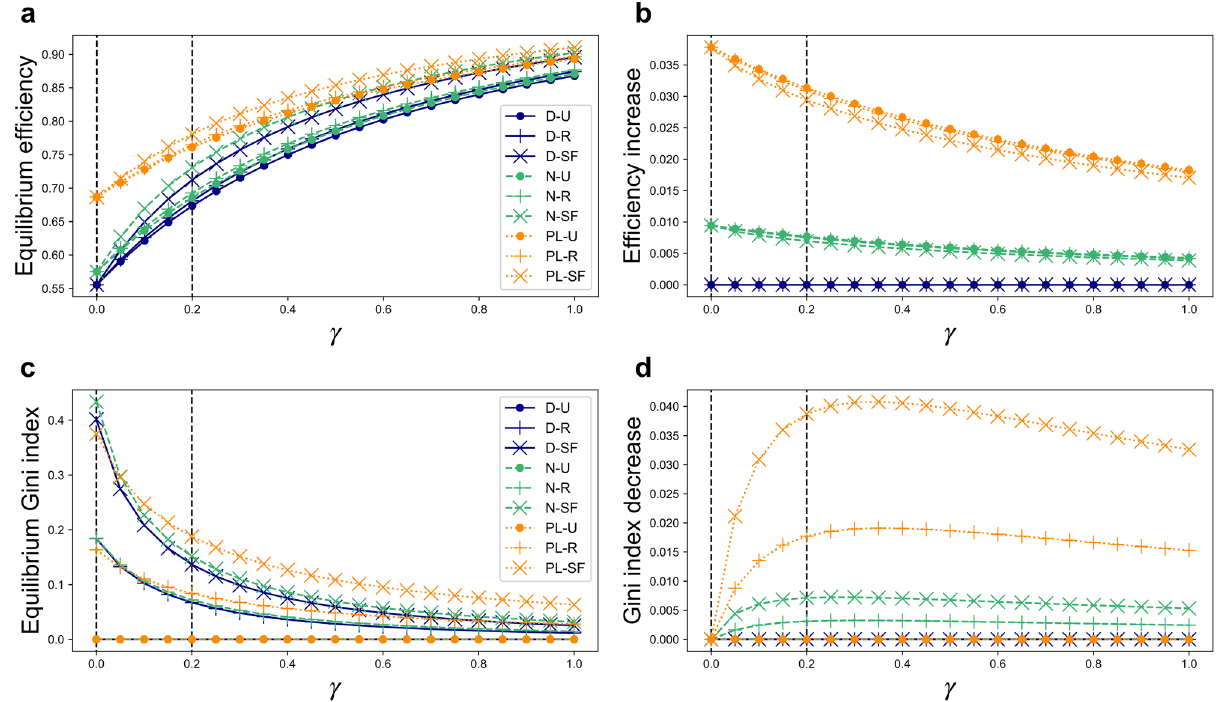
Figure 2. Estimates of ( a ) Ratio of total collective wealth of equilibrium (“Eq”) states relative to efficient (“Ef”) states, F Eq / F Ef ; ( b ) increase in efficiency from equilibrium to steady states (“SS”), ( F SS index of equilibrium states G Eq ; and ( d ) decrease in Gini index from equilibrium to steady states, ( G Eq all as functions of cost parameter γ . Results shown correspond to a uniform capacity scenario with α